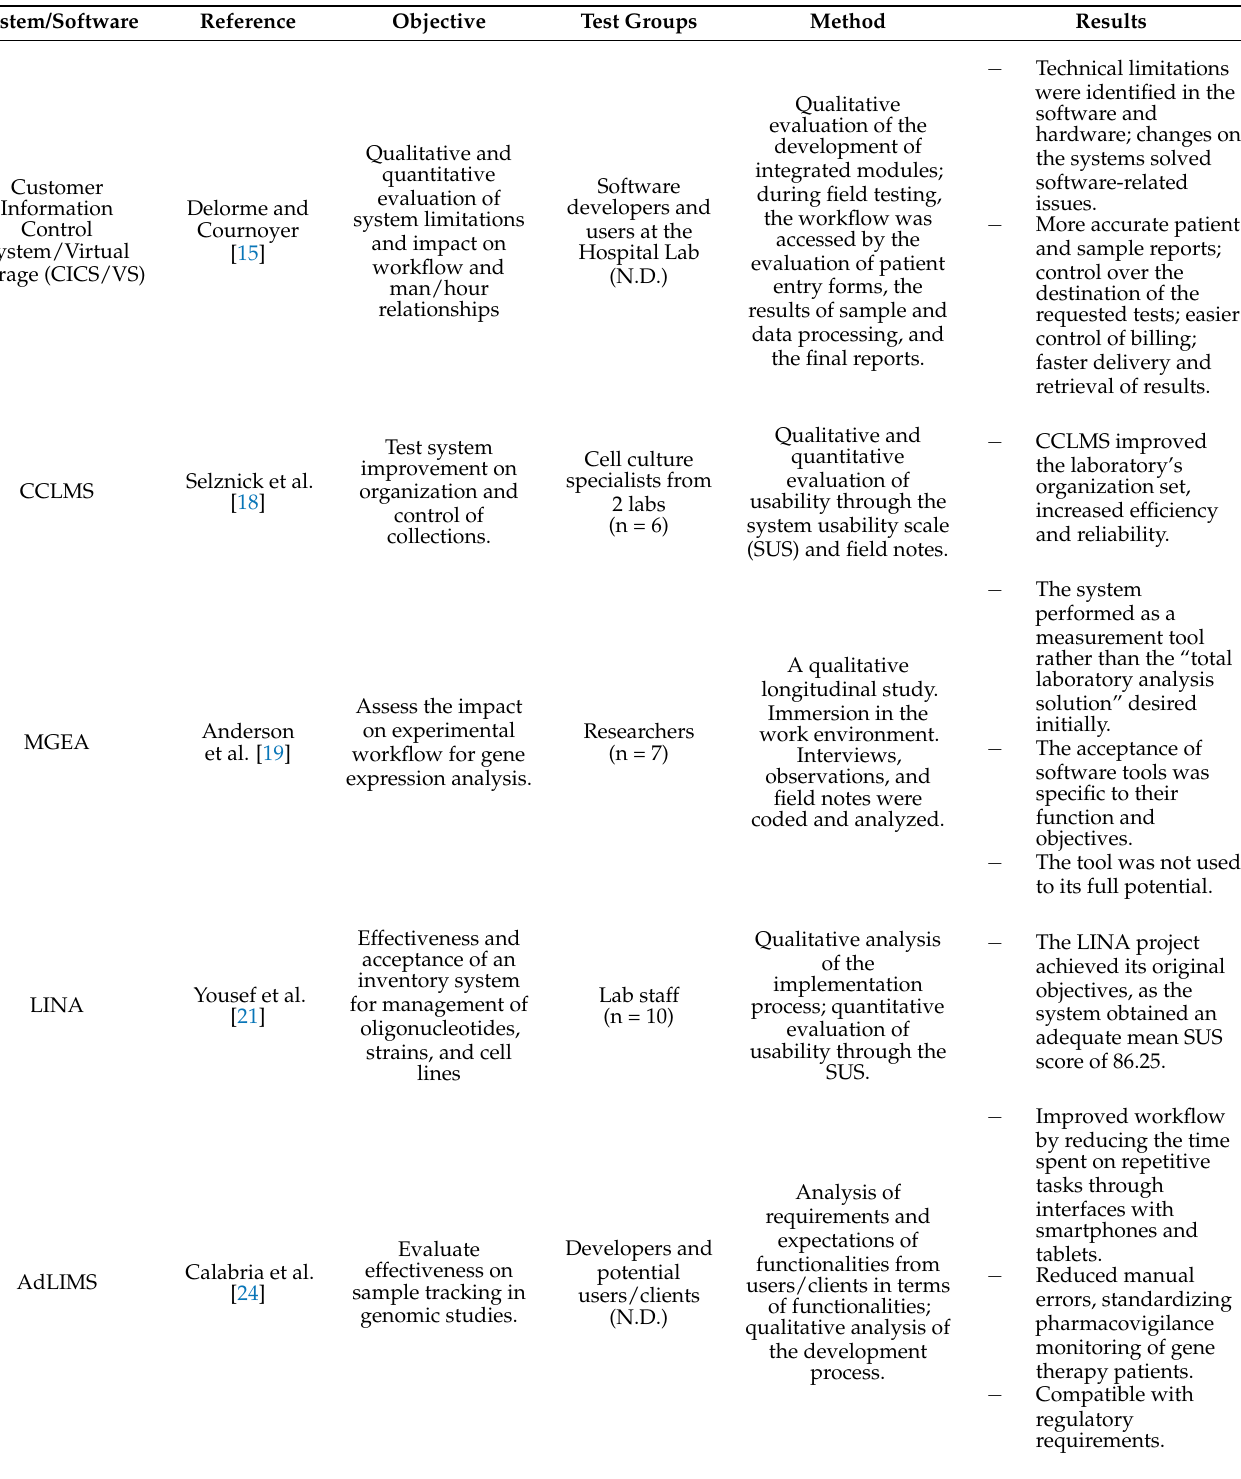
Table 4. Results of the studies that assessed the impact of implementing computerized management systems.